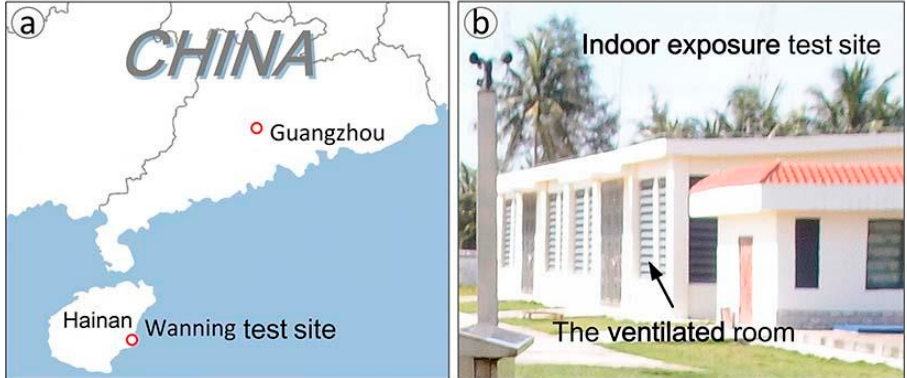
Figure 2. Location of the coastal atmospheric exposure testing station and the indoor exposure testing shed: ( a ) location of Wanning Natural Environment Test Station; ( b ) ventilated rooms for atmospheric exposure tests. Table 2. Atmospheric environmental data for the Wanning Environmental Test Station in 1997.